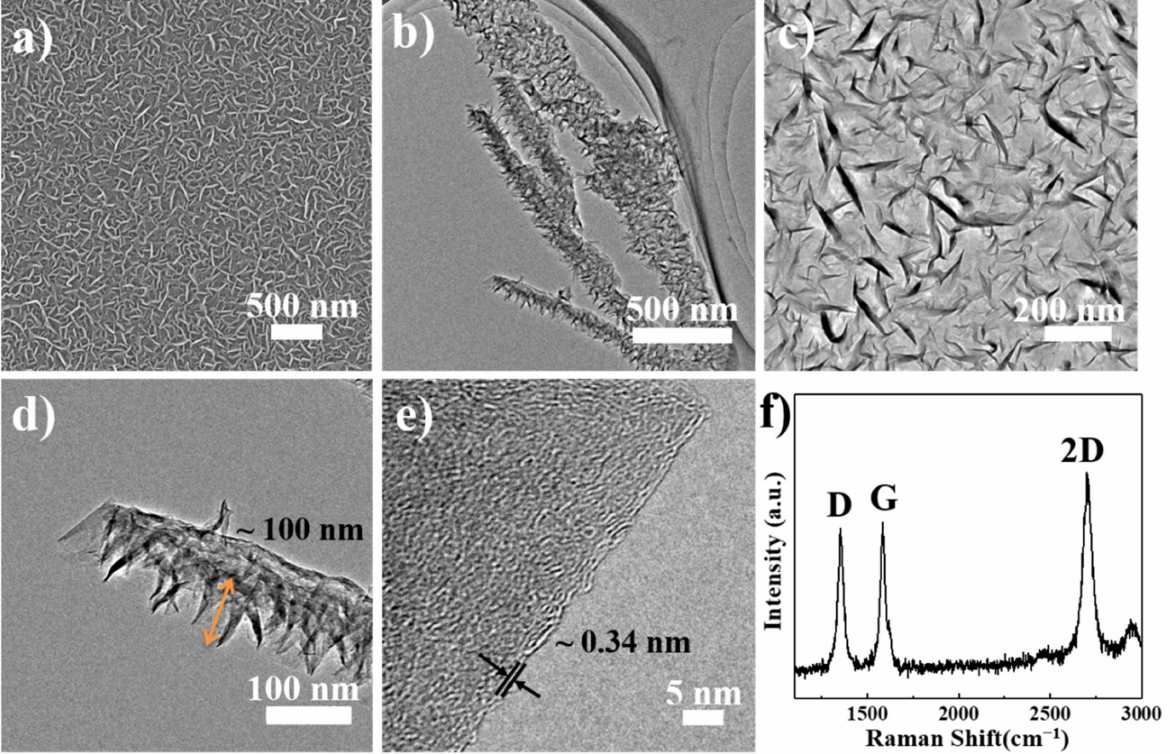
Figure 2. ( a ) SEM image of VFG, ( b – d ) TEM images of VFG, ( e ) HRTEM image of VFG, and ( f ) Raman spectra of